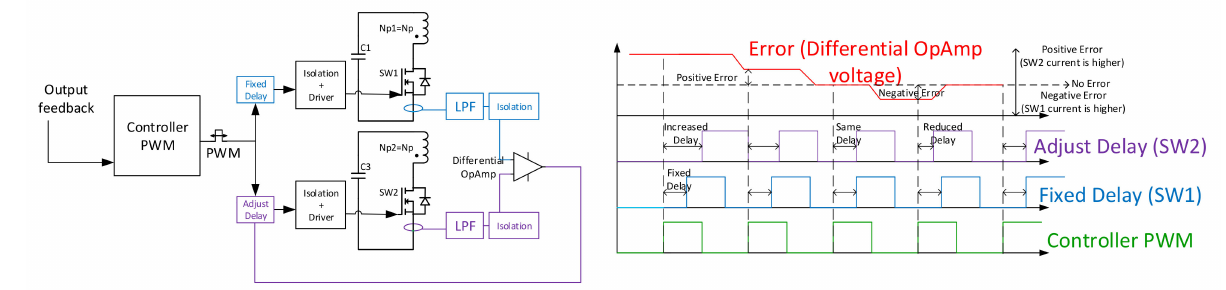
Figure 7. DVFW current sharing control loop schematic ( left ) and timing diagram ( right